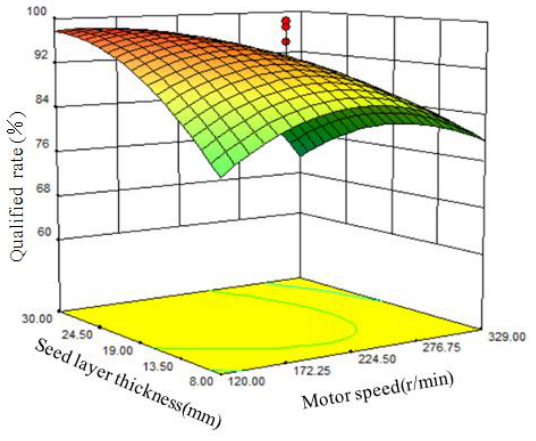
Figure 15. Interaction between motor speed and seed layer thickness.